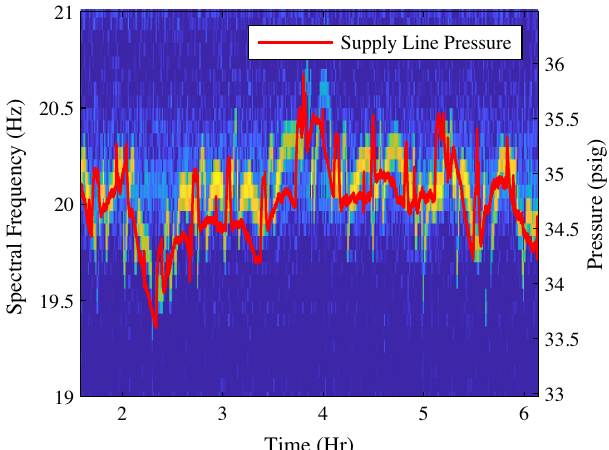
FIG. 22. Spectrogram of the cavity 6 detuning near 20 Hz and the variation in the 2.2 K helium supply line